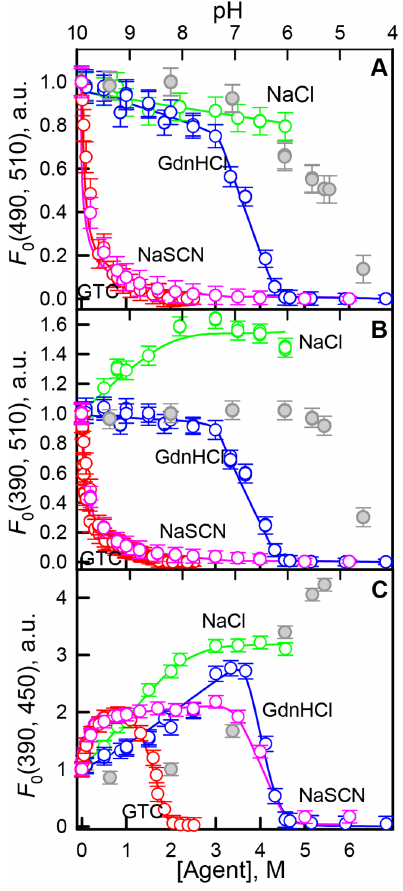
Figure 1. Ionic denaturants and salts effects on fluorescence of anionic and neutral chromophore of sfGFP. Changes in the anionic chromophore fluorescence intensity, l ex =490 nm, l em =510 ( A ) and l ex =390 nm, l em =510 ( B ). Changes in direct fluorescence from neutral form, l ex =390 nm, l em =450 nm ( C ). The value of fluorescence intensity was corrected for the primary inner filter effect (see ‘‘Materials and methods’’ section). Agents used were GTC (red circles) and GdnHCl (blue circles), NaSCN (pink circles) and NaCl (green circles). Data on fluorescence intensity of sfGFP in different pH are shown in gray circles, axis of abscissas for these data is on top.